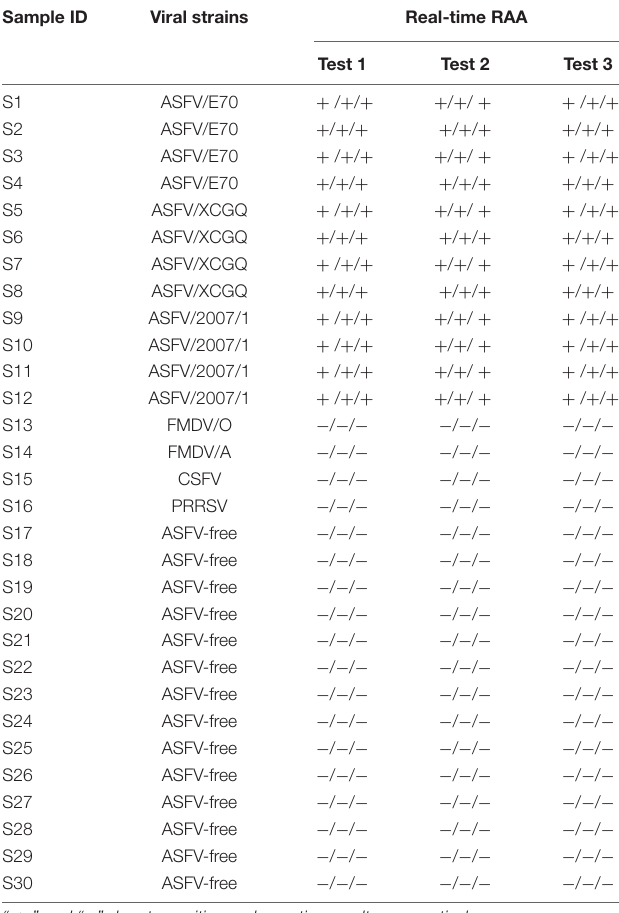
TABLE 3 | Results of repetitive experiments with the real-time recombinase-aid amplification (RAA) assay. Sample ID